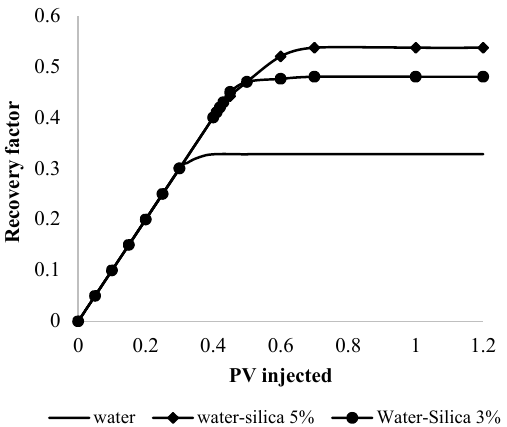
Fig. 10. Oil recovery factor for n-Hexane base nanofluids